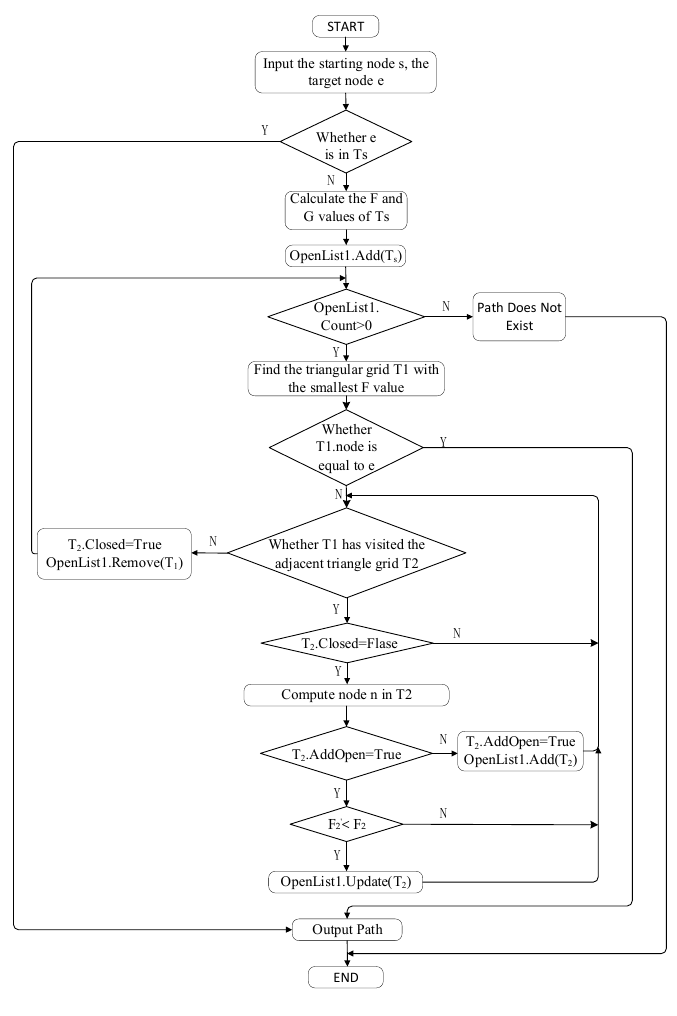
Figure 18. Improvement Path-finding flow chain.